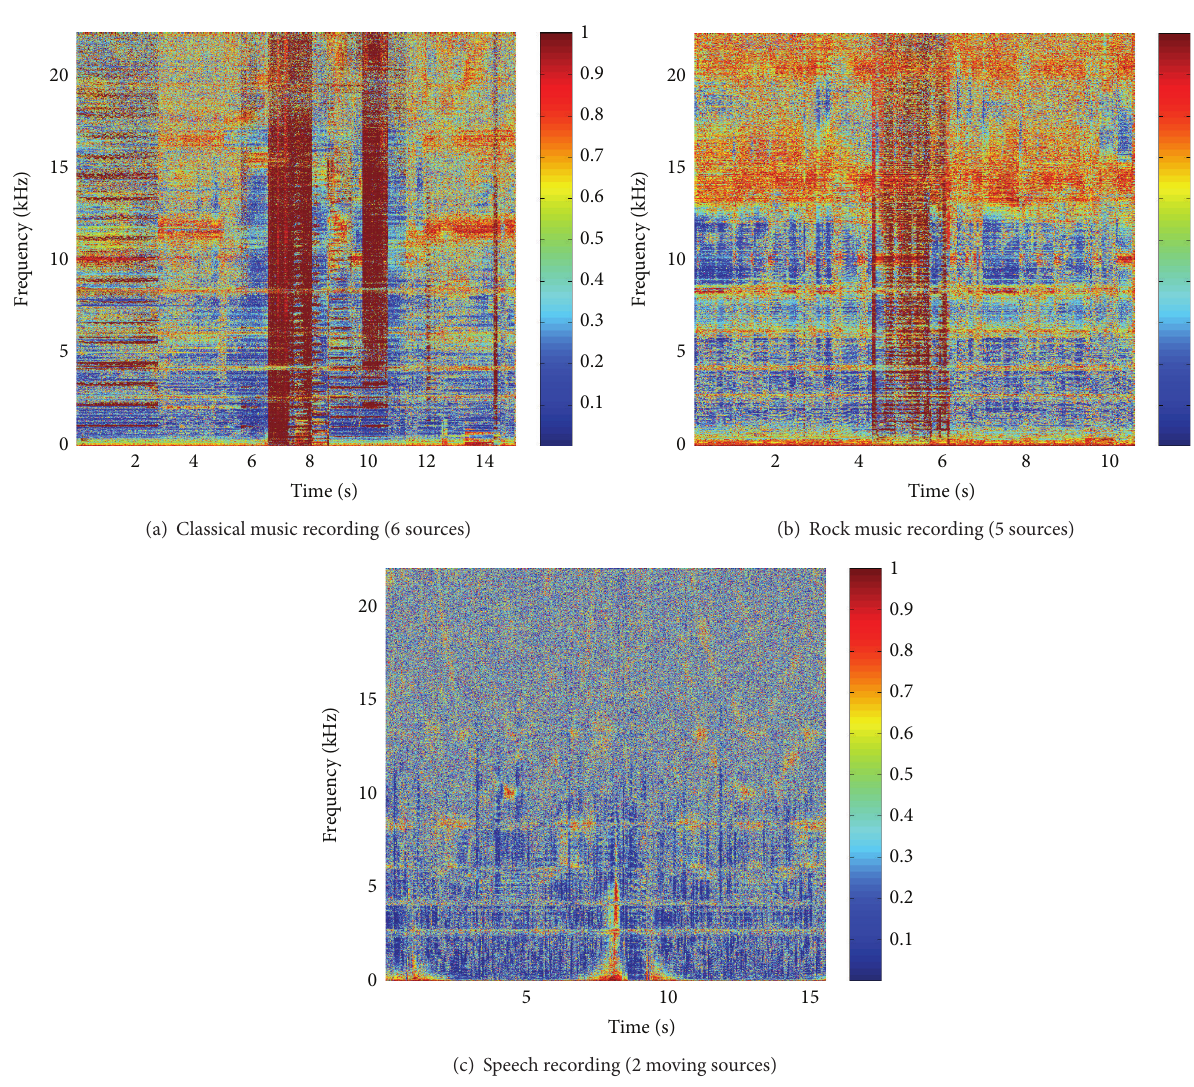
Figure 5: Energy ratio in the time-frequency domain of the beamformer output signals of the source with the second largest energy over the source with the largest energy for the simulated microphone array